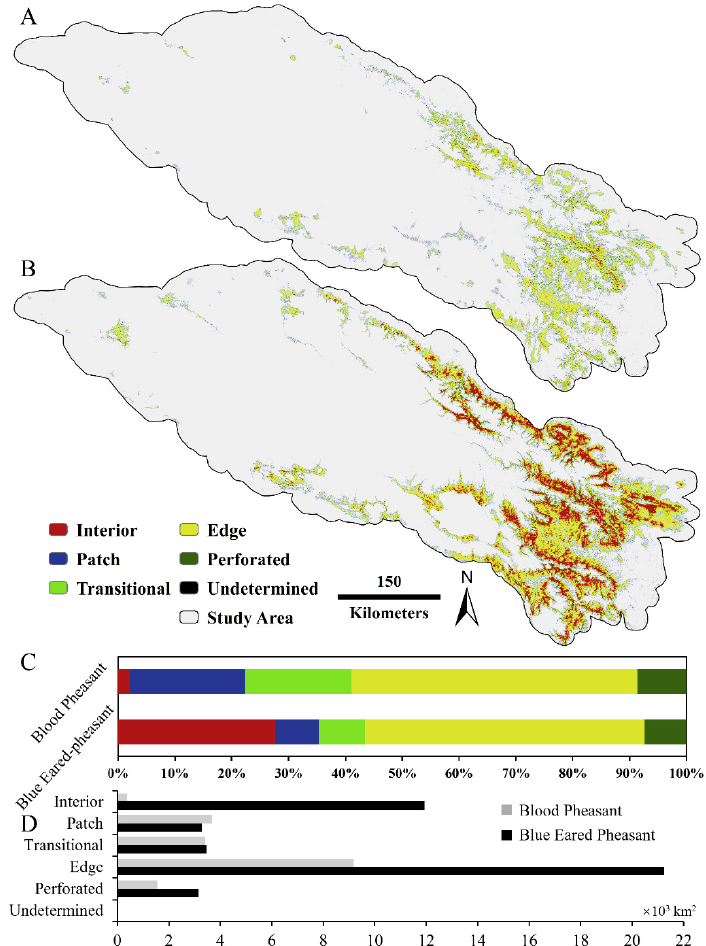
Figure 4. Functional habitat fragmentation categorization: ( A ) blood pheasant and ( B ) blue eared pheasant; ( C ) percentage of different habitat fragmentation and ( D ) total area of different habitat fragmentation.